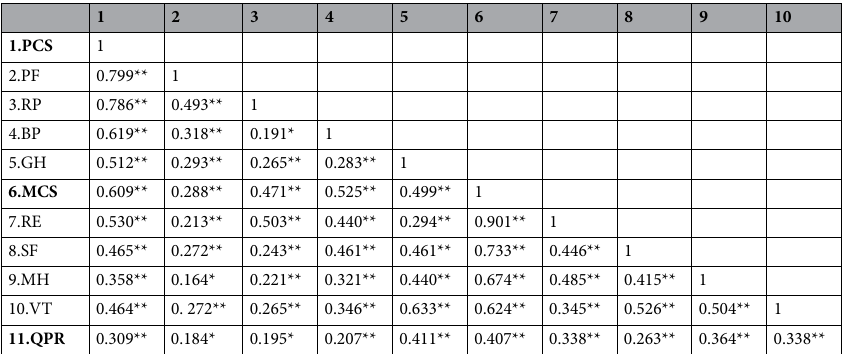
school or higher, and that of 47.38% was junior high school or lower. In total, 37.79% of participants had monthly incomes of less than 3000 RMB, 48.26% had monthly incomes of 3001–6000 RMB, and 13.95% had monthly incomes of more than 6000 RMB. Most participants had three or more chronic diseases ( N = 236, 68.60%). The mean ADL score of the participants was 24.10 ± 13.98. Approximately 29.07% of participants had intracerebral hemorrhage ( N = 50) and 70.93% had cerebral infarction ( N = 122). Most participants had hemiplegia ( N = 163, 94.77%), while a few of them had aphasia ( N = 44, 25.59%) or dysphagia ( N = 6, 3.49%). Comparisons of stroke patients’ QOL and QPR scores. Comparisons of PCS and MCS based on demographic characteristics are shown in Table 1. Participants older than 60 years with a lower educational level, lower monthly incomes, higher disability, intracerebral hemorrhage, hemiplegia, aphasia or dysphagia were found to have lower PCS or MCS. There were no significant differences in PCS and MCS relating to gender, marital status, and chronic conditions. Comparisons of PCS and MCS before and during the COVID-19 pandemic are shown in Fig. 1. Before the pandemic, the mean PCS and MCS values among the patients with stroke were 37.98 ± 14.52 and 43.50 ± 20.94, respectively. During the pandemic, these scores were 44.20 ± 18.92 and 54.24 ± 19.08. The overall PCS and MCS and the PF, RP, GH, RE, SF, VT sub-scores were significantly higher during the pandemic than before the pandemic. Comparisons of PCS and MCS considering thoughts about the pandemic are shown in Table 2. For each item, scores > 3 were used as grouping criteria for pandemic stress. During the pandemic, more than half of the participants felt that the impacts of the pandemic on their daily life were very low, low, or medium ( N = 100, 58.14%), and less than half of them felt that the impacts were high or very high (N = 72, 41.86%). Most of the participants felt that the risk of infection was very low, low, or medium ( N = 123, 71.51%), and few of them felt that the risk was high or very high (N = 49, 28.49%). Most of the participants felt that their worries about the pandemic were very low, low, or medium ( N = 126, 73.26%), and few of them felt that their worries were high or very high ( N = 46, 26.74%). The comparisons showed that participants with lower pandemic stress had a significantly higher PCS and/or MCS. The mean QPR score of the participants was 56.74 ± 13.26 (Table 2). Patients had higher QPR scores during the pandemic (59.04 ± 11.95) than before the pandemic (54.45 ± 14.11). During the pandemic, those who felt that their worries about the pandemic were high or very high had lower QPR scores.